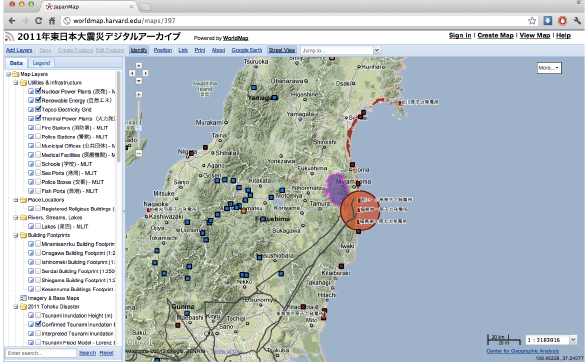
Figure 11. Japan Map powered by Harvard World